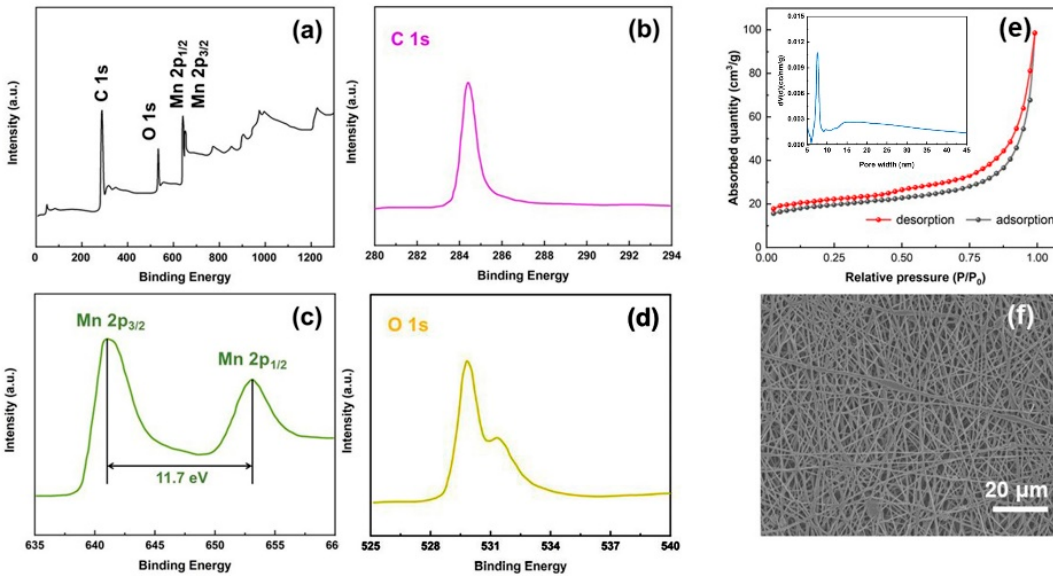
Figure 3. XPS spectra: ( a ) wide-scan and narrow-scan at ( b ) C 1s region, ( c ) Mn 2p region, and ( d ) O 1s region for the as-prepared Mn3O4/CNFs. ( e ) N 2 adsorption/desorption isotherm of the Mn 3 O 4 /CNFs sample and their pore size distribution curve (inserted). ( f ) SEM photographs of the Mn 3 O 4 /CNFs.